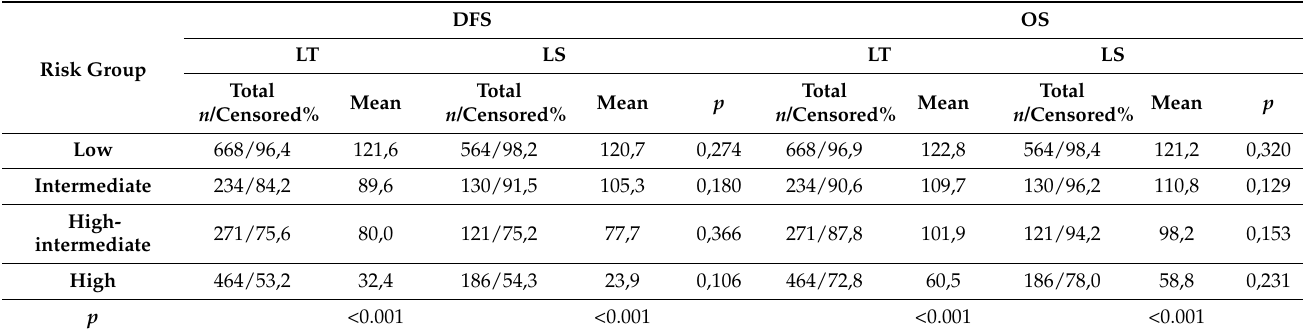
Table 3. Comparison of DFS and OS rates between groups with respect to the ESMO-ESGO-ESTRO risk classification